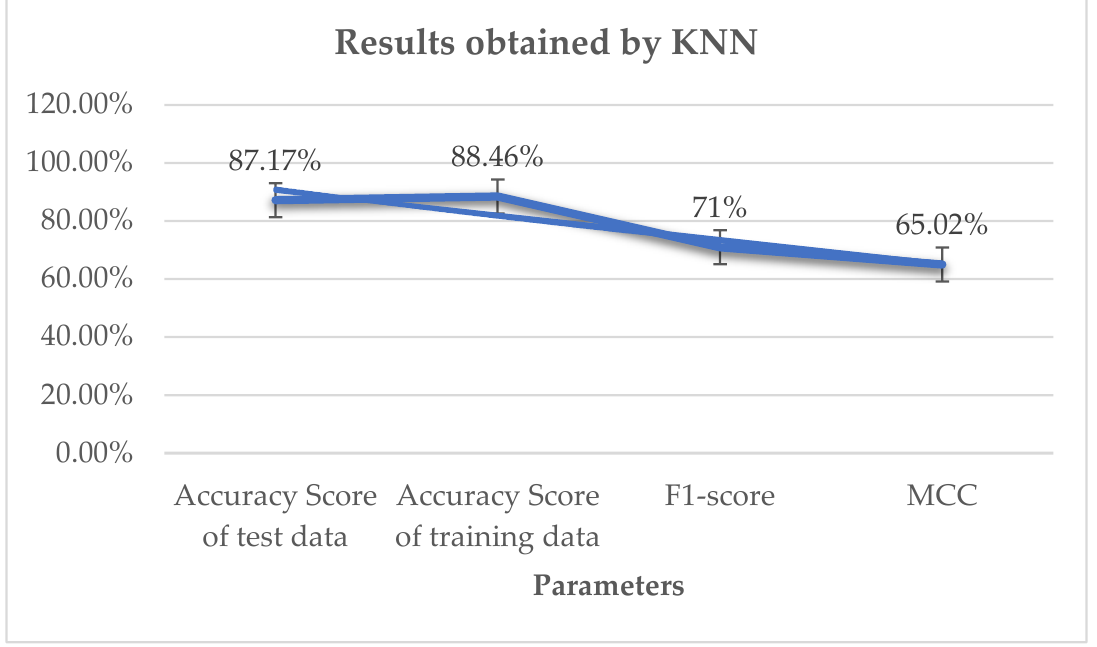
Table 7. An overview of evaluation